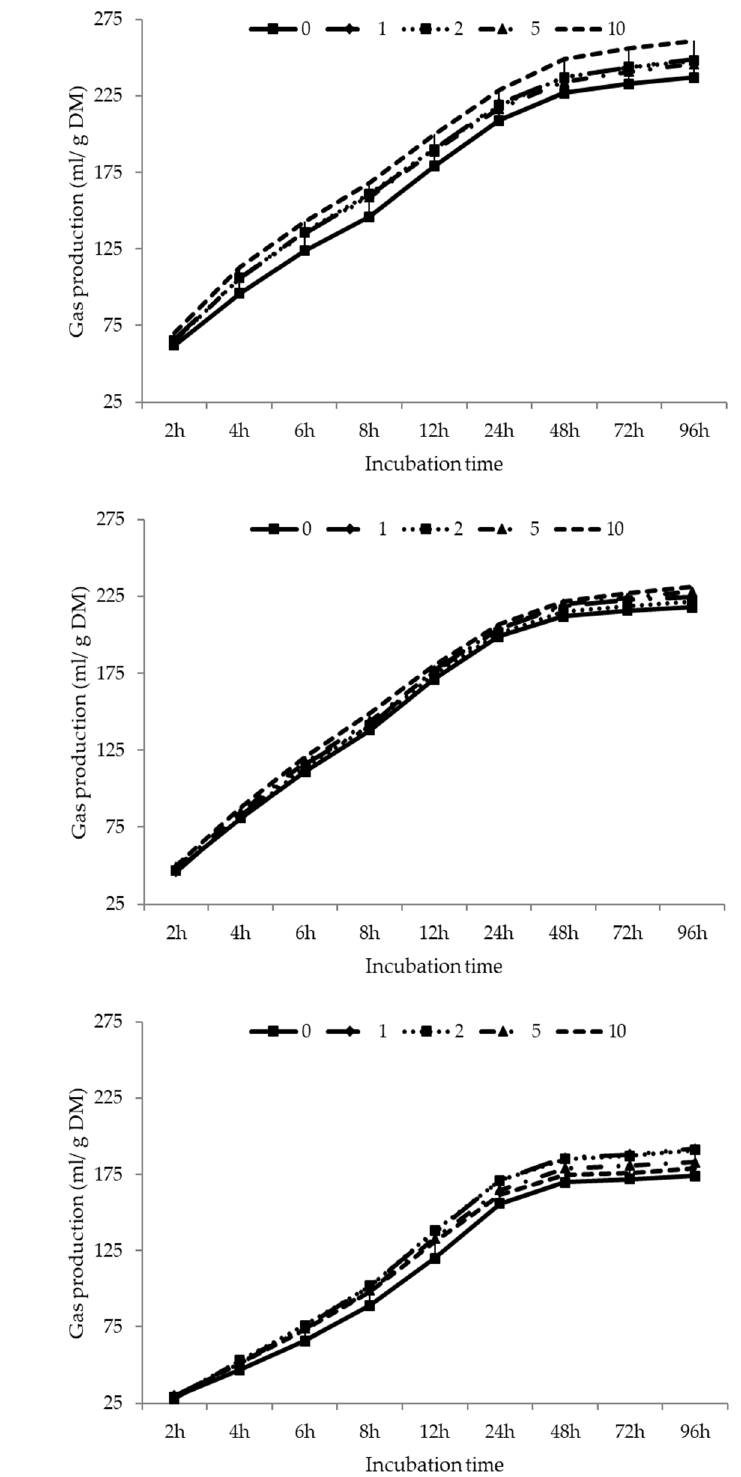
Figure 2. Effects of EFE supplemented to pretreated SFH (( A ): SFH out , ( B ): SFH NaOH , ( C ): SFH urea ) on the volume of in vitro gas production. Table 4. Effects of EFE supplemented to pretreated SFH (SFH out , SFH NaOH , SFH urea ) on the kinetics of in vitro gas production.